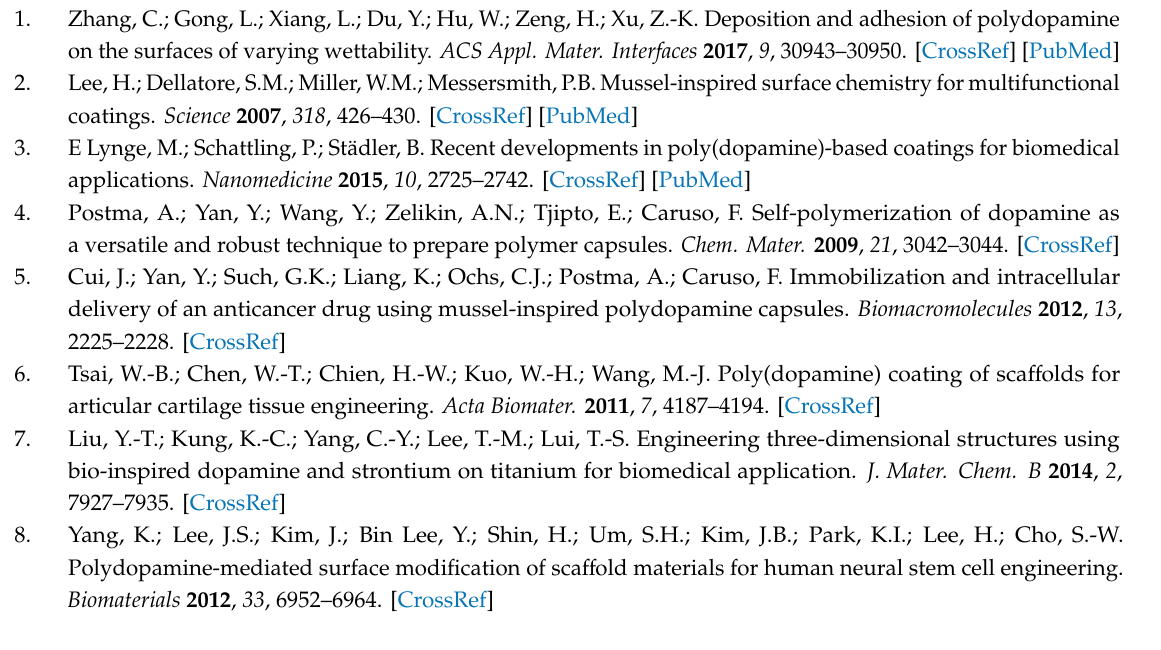
Figure S1: Nanoparticle size distribution of AuNPs (a), and AgNPs (b); Figure S2: FT-IR spectrum of PDA thin film onto the glass slide; Figure S3: The preliminary study for the cell number optimization and optic images of A549 and CaCO2 cell lines incubated with an initial cell number of 7500 cells per well onto the bare and PDA coated glass; Figure S4: violet staining of A549 and CaCO2 cell lines onto di ff erent thin films at 20 × magnification; Table S1: The number density of adhered cells onto the di ff erent